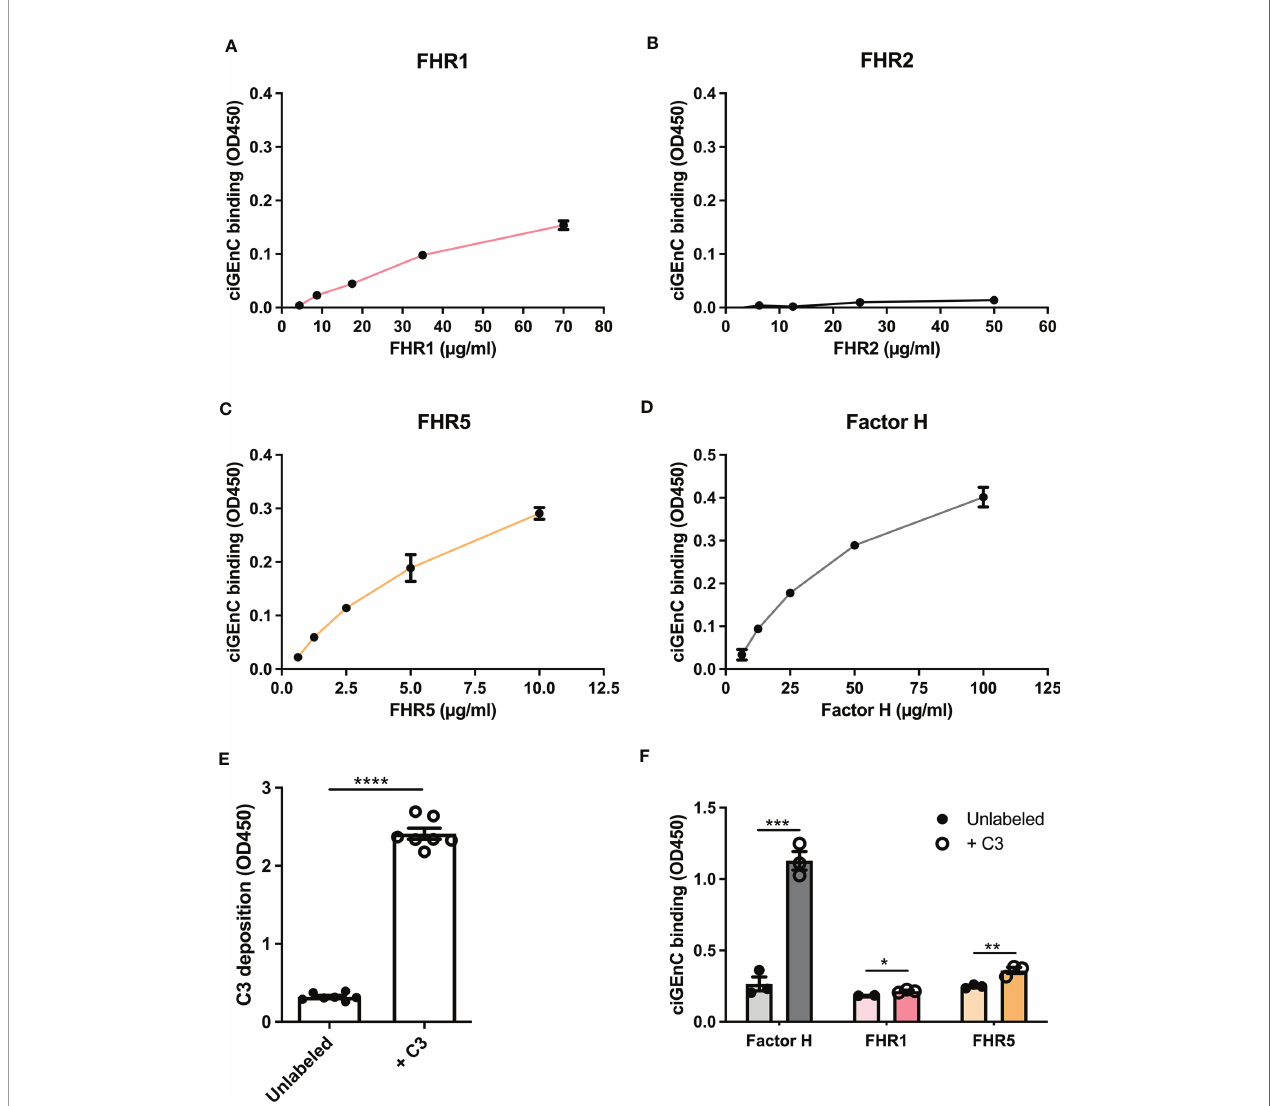
FIGURE 1 | Factor H and recombinant FHR1 and FHR5 bind to glomerular endothelial cells in vitro. Factor H-related proteins (FHRs) 1 (A) , 2 (B) and 5 (C) and factor H (D) were titrated on conditionally immortalized glomerular endothelial cells (ciGEnCs) and binding was determined using ELISA. Labeling antibody-sensitized ciGEnCs with C3b using classical pathway proteins (n=7) (E) signi fi cantly increased binding of factor H and FHR1 and FHR5 (n=3) (F) . (*p < 0.05, **p < 0.01, ***p < 0.001, ****p < 0.0001 vs